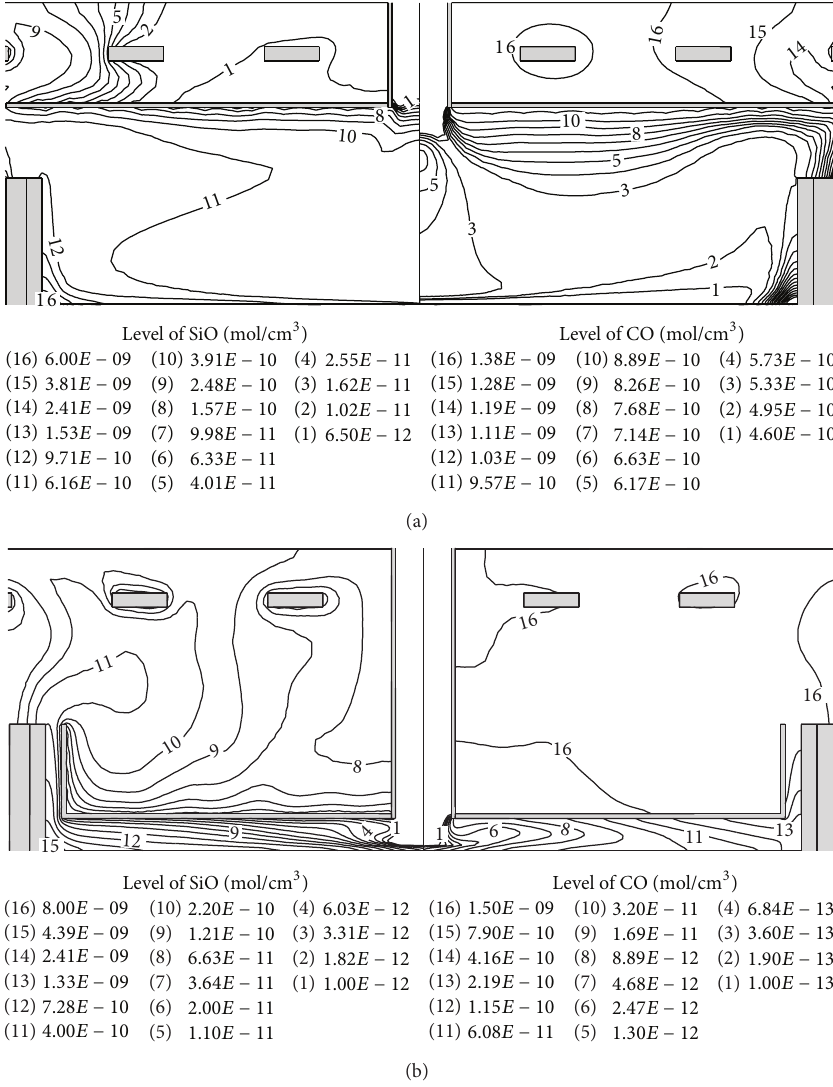
Figure 6: Distributions of SiO (left) and CO (right) concentration above the melt free surface for different cover designs with surface reaction: (a) flat cover and (b) U